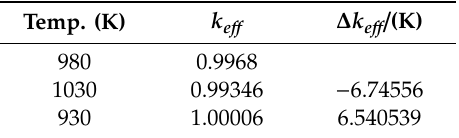
Table 2. Initial steady state calculations and determination of the feedback e ff ect for a close to eutectic system with a radius of 210